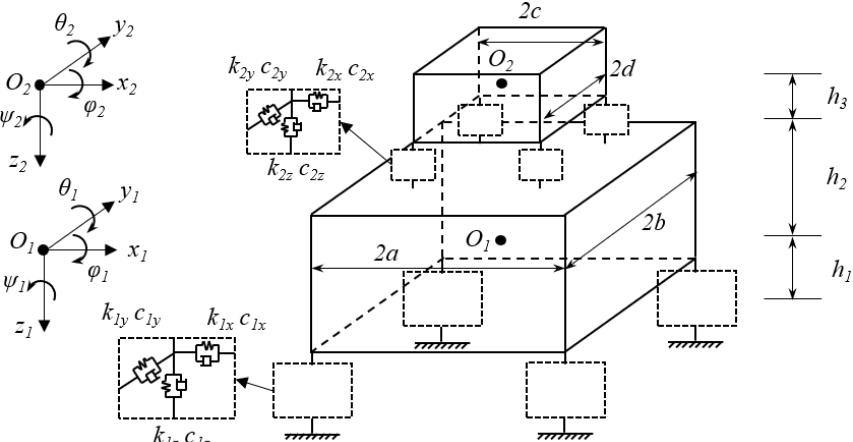
Figure 1. Schematic diagram of an MDOF